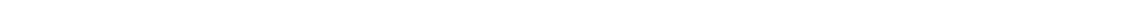
Fig. 8 2i fail to maintain telomeres in ESC culture without feeders. a Representative telomere Q-FISH images of OG4 ESCs cultured under three culture conditions. Blue, chromosomes stained by DAPI; green dots, telomeres. Red arrowhead indicates chromosome fusion. Scale bar, 10 μ m. b Histogram displaying distribution of relative telomere length shown as TFU. Green line indicates medium telomere length. Mean ± s.d. of telomere length is shown above each panel. At P16, P < 0.0001 (serum + F vs serum + F + 2i; serum + F + 2i vs N2B27 + 2i; serum + F vs N2B27 + 2i). Wilcoxon – Mann – Whitney rank sum test. c , d Frequency of telomere signal-free ends ( c ) and chromosomal fusion ( d ). ns not signi fi cant ( P > 0.05), ANOVA with PLSD was used for the statistical analysis. e Distribution of chromosome numbers in ESCs cultured under three conditions. n = 30 spread counted for each group. ns not signi fi cant ( P > 0.05). χ 2 test. f Pup (black coat) born from OG4 ESCs cultured in N2B27 + 2i/L condition for four passages by TEC assay. g Comparison of expression levels of Dnmt3b and Zscan4, telomere lengths and developmental pluripotency of ESCs cultured under the three culture conditions (all added with LIF). GT germline transmission, TEC tetraploid embryo complementation, ↑ increased, ↓ decreased, ↑↓ vary in different cell lines, √ achieved, a,